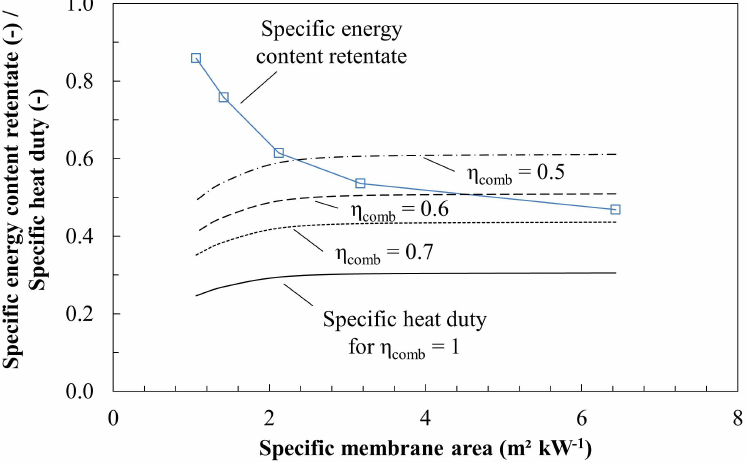
Figure 8. Comparison of specific energy content of retentate with specific heat duty for different combustor